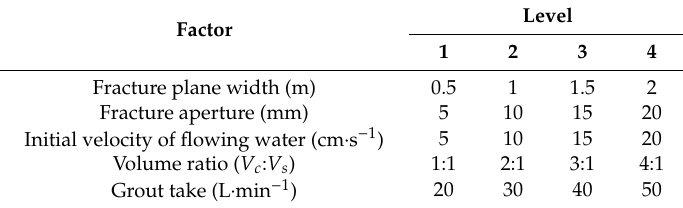
Table 1. Test values of influencing factors used in the study.